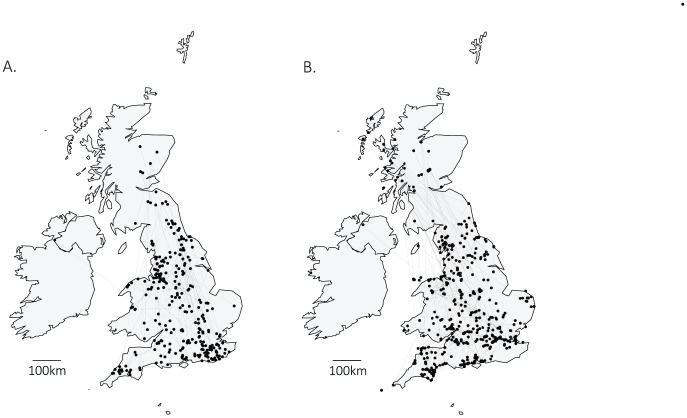
Maps showing the last three UK sites visited and by A) anglers and B) canoeists who visited more than one catchment within a fortnight and failed to clean or dry their kit between uses.Points show the sites and lines connect sites visited by an individual within a fortnight.